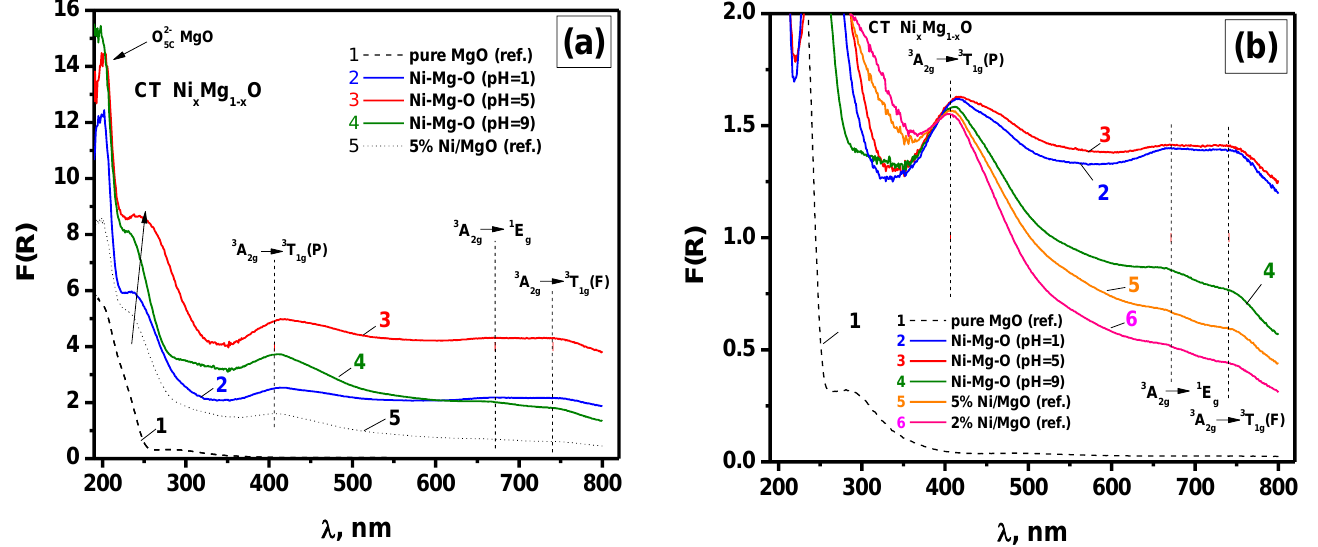
Figure 4. Initial ( a ) and normalized ( b ) UV-vis spectra of the Ni-Mg-O samples obtained at various pH and reference MgO and NiO/MgO samples.